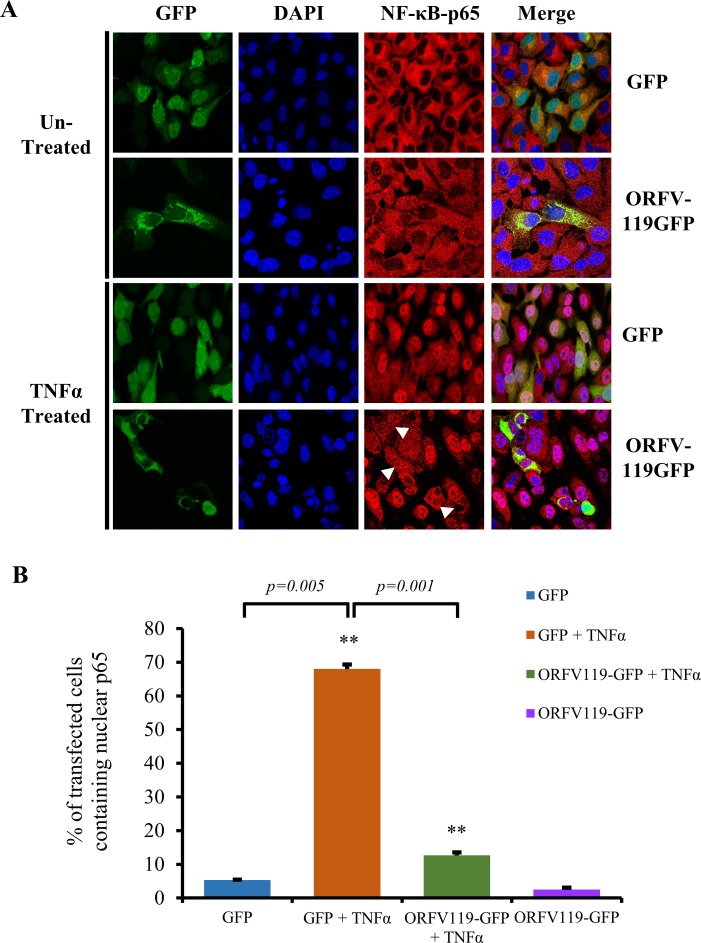
Effect of ORFV119 on TNFα-induced NF-κB-p65 nuclear translocation.(A) HeLa cells were transfected with control plasmid (pEGFP-N1) or pORFV119-GFP, which expresses ORFV119 fused to GFP. At 12 h post-transfection, cells were treated with TNFα (20ng/ml) for 30 min and processed for immunofluorescence. Green, GFP; Red, NF-κB-p65; Blue, DAPI. (B) Cells were counted (n = 500 cells/slide) and results are shown as percentage of GFP or ORFV119GFP expressing cells with nuclear NF-κB-p65. Results are mean values of three independent experiments (**P<0.01, GFP vs GFP + TNFα and GFP + TNFα vs ORFV119-GFP + TNFα). White arrows indicate ORFV119GFP expressing cells with reduced nuclear NF-κB-p65.